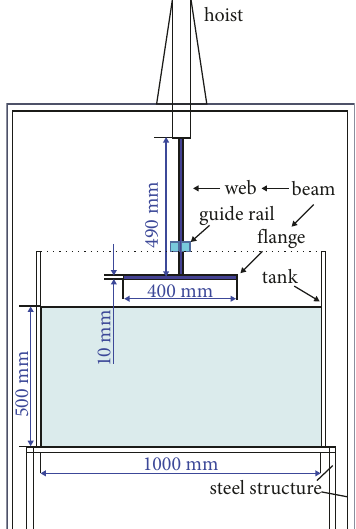
Figure 2: Model device diagram.